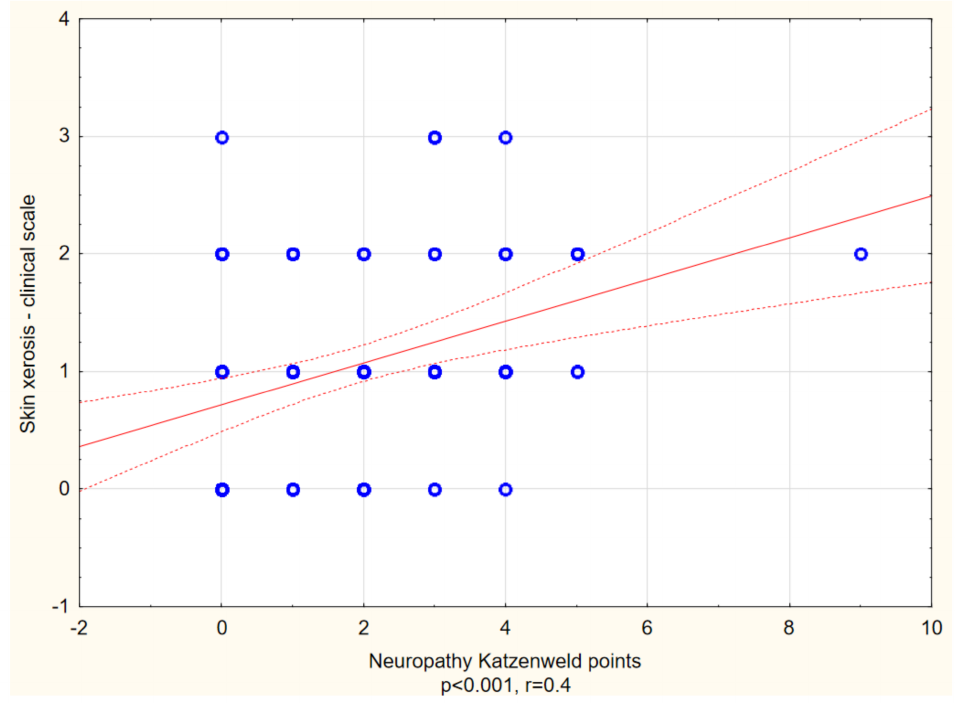
Figure 3. Spearman’s correlation analysis revealed a significant positive link between skin xerosis assessed in clinical scale and neuropathy assessed with Katzenwadel neuropathy scale (R = 0.4, p <